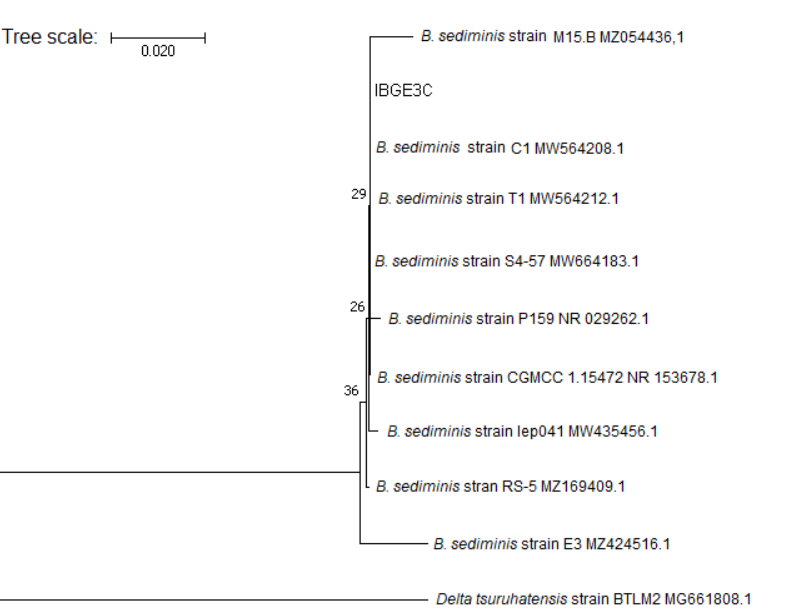
Figure 8. Maximum likelihood (ML) phylogenetic tree of Brevibacterium sediminis strain IBGE3C, and some of its closest phylogenetic relatives. Bootstrap values are referred to by the numbers on branches. Delftia tsuruhatensis strain BTLM2 MG661808.1 served as an outgroup.